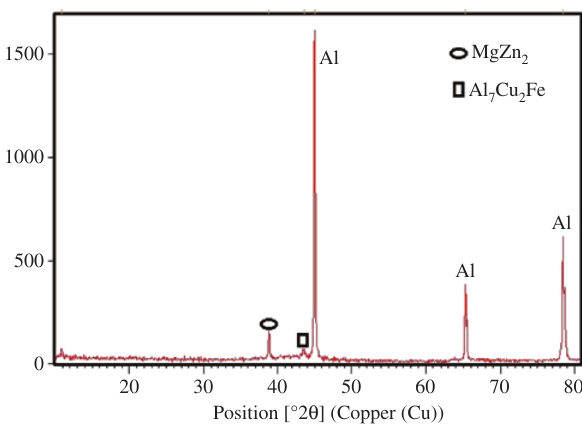
Figure 5: XRD pattern of bulk